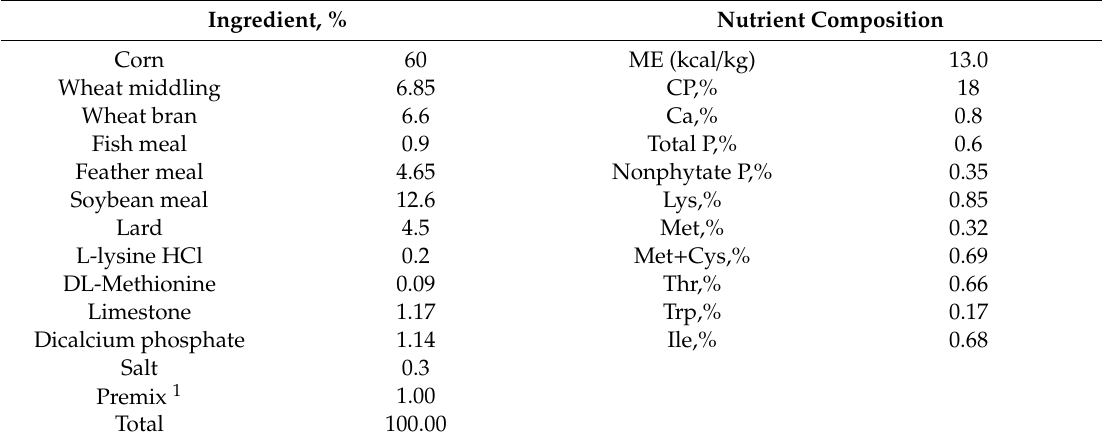
Table 1. Composition and nutrient levels of experimental diets (% as fed-basis, 22 day–126 day). Ingredient, % Nutrient